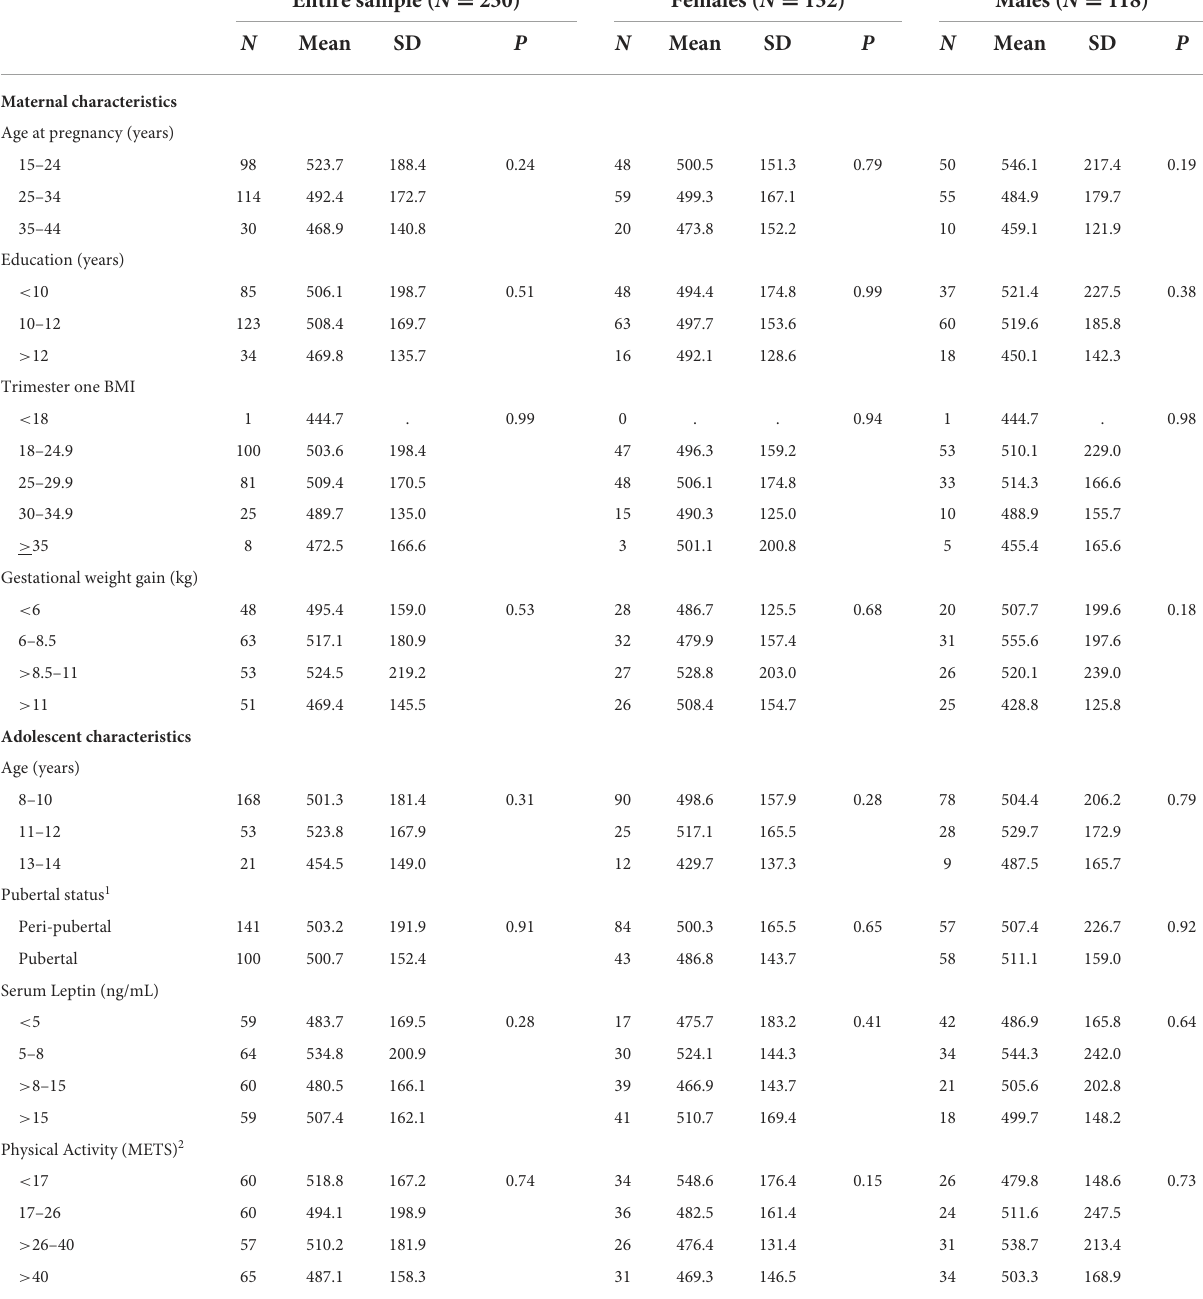
TABLE 2 Differences in the distribution of adolescent 8-isoprostane (pg/mL) across maternal and adolescent sociodemographic